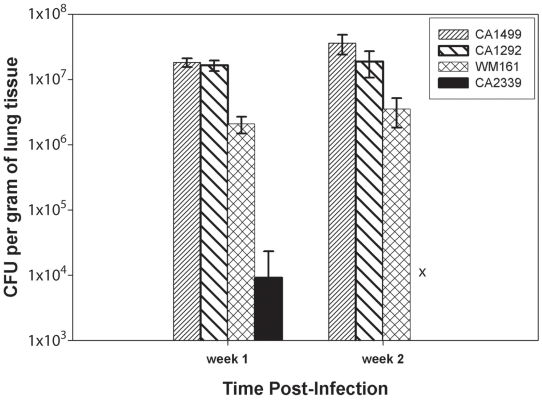

C. gattii organ load determination.Male, BALB/c mice were infected intranasally with 1×105
C. gattii yeast cells intranasally. After one and two weeks post-infection, lungs and brains from three infected mice were removed asceptically and fungal load was determined by CFU enumeration as described in materials and methods. The bar diagram represents mean ± SD of CFU per gram of lung tissues obtained from three mice each for different C. gattii strains.